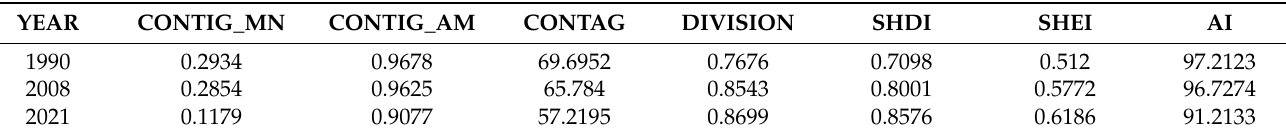
Table 2. Landscape metrics at landscape